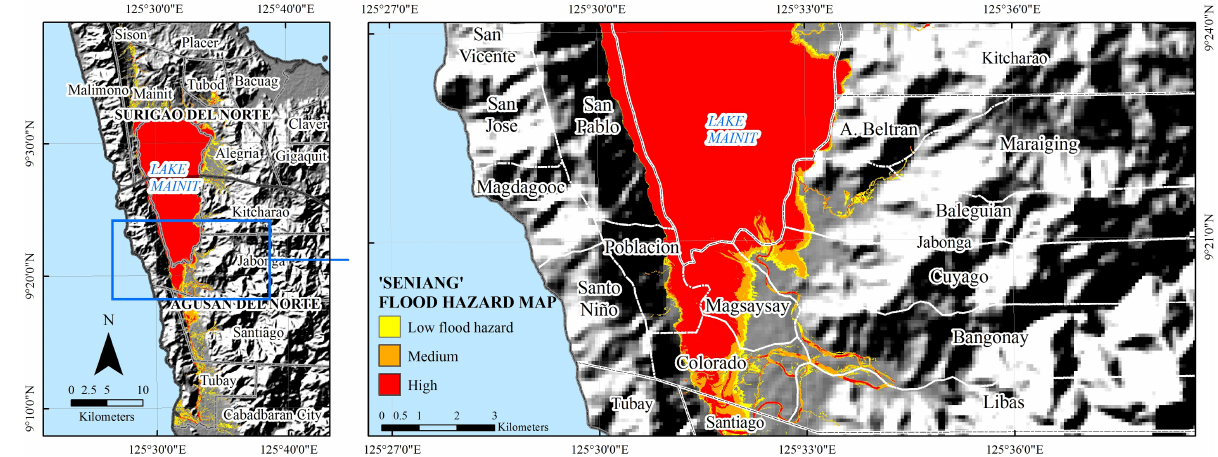
Figure 3: Flood hazard map of Jabonga for the Seniang